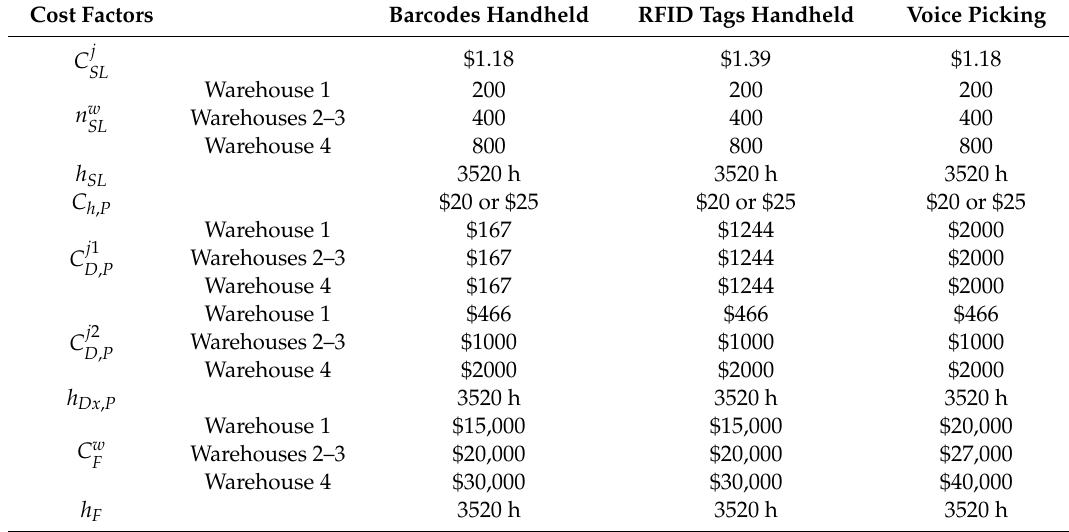
Table 4. Cost components